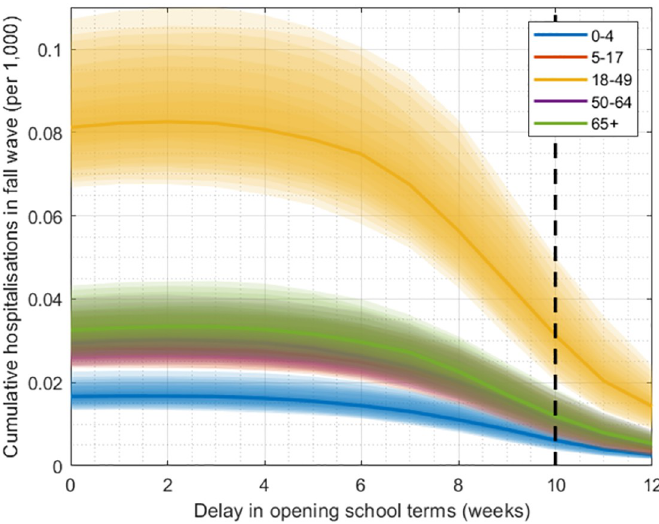
Fig 4. Projected hospitalisations (California) with delayed school openings, assuming the same efficacy and timing of vaccine rollout as occurred in 2009. Each colour shows a different age group as indicated by the legend, while shaded areas show 25–75th percentiles, with 2009 vaccination coverage/efficacy. The vertical dashed line represents the candidate delay of 10 weeks used to illustrate our decision framework in Fig 5.